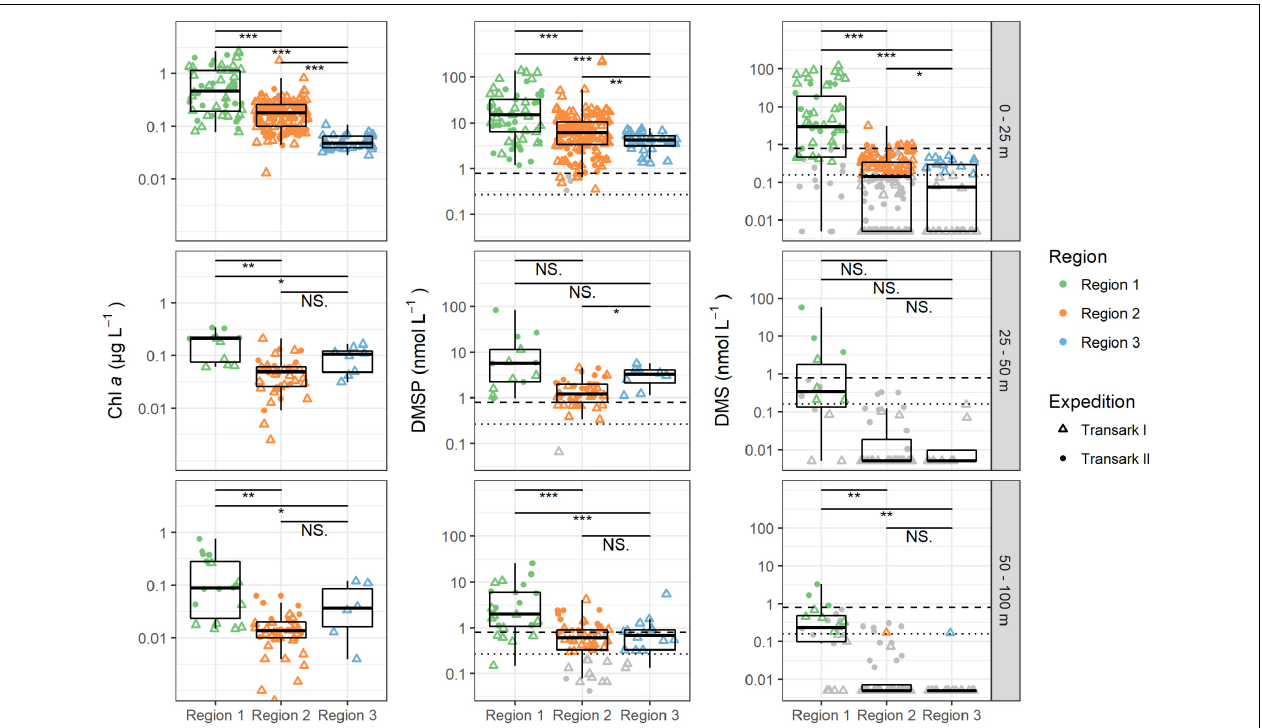
FIGURE 2 | Chlorophyll a (Chl a ), dimethylsulfoniopropionate (DMSP), and dimethylsulfide (DMS) concentrations in the upper 100 m water column during expeditions Transark I (triangles) and Transark II (circles) in the three regions. Data, of which the measured value was below the limit of quantification (LOQ), is shown in gray (Transark I: 0.16 nmol L − 1 DMS and 0.27 nmol L − 1 DMSP, dotted lines; Transark II: 0.8 nmol L − 1 DMS and DMSP, dashed lines). In Region 1 depth 0–25 m, 25% of the DMS measurements were < LOQ, while for all other regions and depths ≥ 50% were < LOQ. This value was even higher with > 93% for regions 2 and 3 for depths below 25 m. DMSP or DMS = 0 are shown as 0.005 due to logarithmic y -axis. Confidence levels of Welch’s t -test for significant differences between sample groups: 0.0001 ≤ ∗∗∗ p < 0.001 ≤ ∗∗ p < 0.01 ≤ ∗ p ≤ 0.05 < NS. ≤ 1.